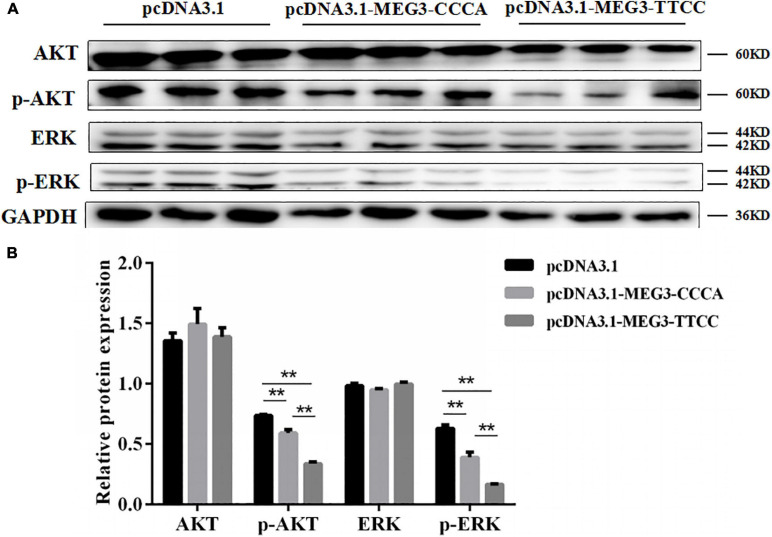
Overexpression of MEG3 haplotypes inhibited PI3K/AKT and MAPK/ERK1/2 signaling pathways in SCs. Western blotting analysis of the expression of AKT, p-AKT, ERK1/2, and p-ERK1/2 (A) and their relative expression level (B) in pcDNA 3.1 (+), pcDNA3.1-MEG3-CCCA, or pcDNA3.1-MEG3-TTCC groups. The significance test: **P < 0.01.